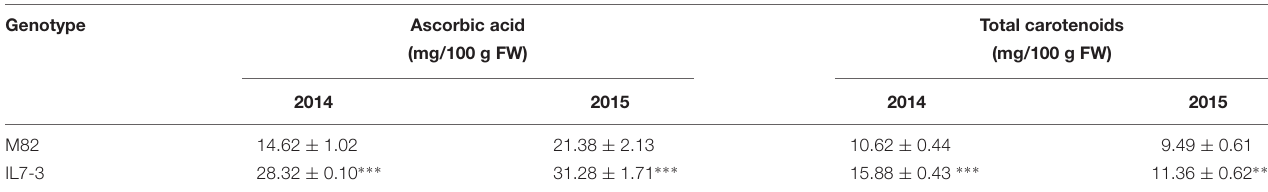
TABLE 1 | Evaluation of metabolite content (ascorbic acid, and total carotenoids, mean and standard error) in mature red fruit of genotypes M82 and IL7-3 in the years 2014 and 2015. Genotype Ascorbic